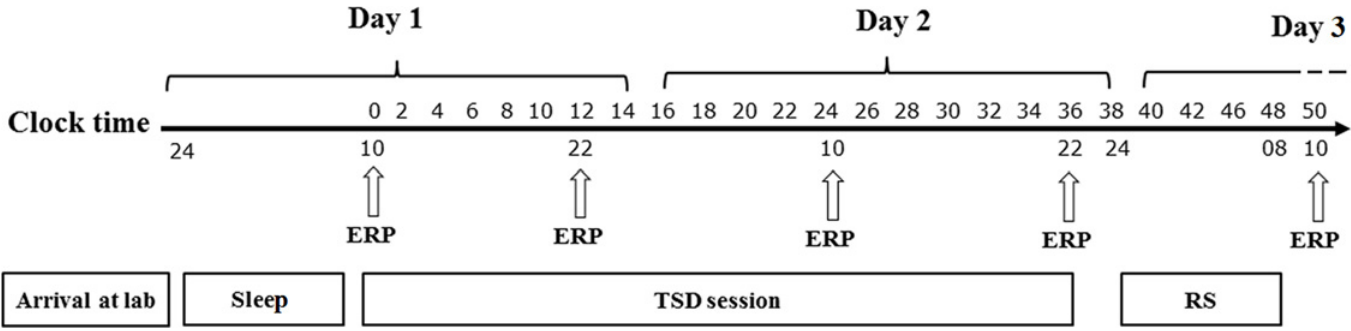
Fig 2. Schematic diagram of the experimental design. TSD started after a routine nocturnal sleep period. The clock time axis represents the course of TSD and RS. TSD started at 10:00 pm at Day 1. The subjects needed to keep awaking for 36 h. Each arrow below the clock time axis represents the time points performed the Go/No-go task and EEG recording synchronously. The interval of the tasks was 12 hours during the TSD session. At the time point of 24:00 pm, Day 2, all participants accepted an 8-h recovery sleep.